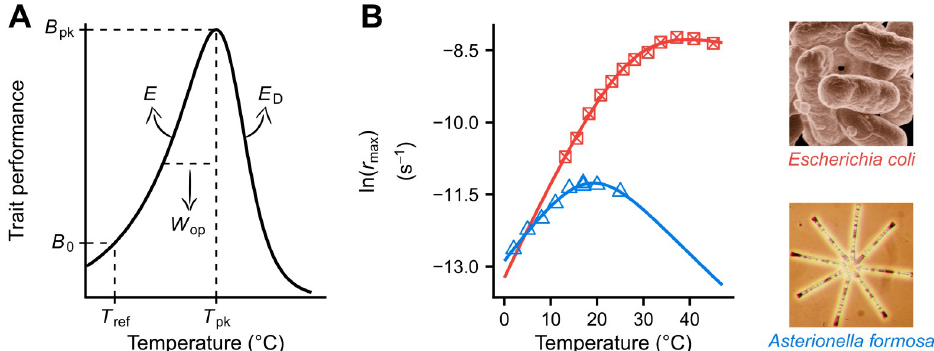
Fig 1. The TPC of ectotherm metabolic traits, as described by the Sharpe-Schoolfield model [5]. (A) T pk (K) is the temperature at which the curve peaks, reaching a maximum height that is equal to B pk (in units of trait performance). E and E D (eV) control how steeply the TPC rises and falls, respectively. B 0 (in units of trait performance) is the trait performance normalised at a reference temperature ( T ref ) below the peak. In addition, W op (K), the operational niche width of the TPC, can also be calculated a posteriori as the difference between T pk and the temperature at the rise of the TPC where B ( T ) = 0.5 � B pk . We note that we use W op instead of a metric that captures the entire TPC width because previous studies have shown that species generally experience temperatures below T pk [6, 7]. Thus, W op is a measure of the thermal sensitivity of the trait near typically experienced temperatures. (B) TPCs of individual- and population- level traits (such as r max ) are usually well described by the Sharpe-Schoolfield model. The raw data for panel B are available at https://doi.org/10.6084/m9.figshare.12816140.v1. TPC, thermal performance